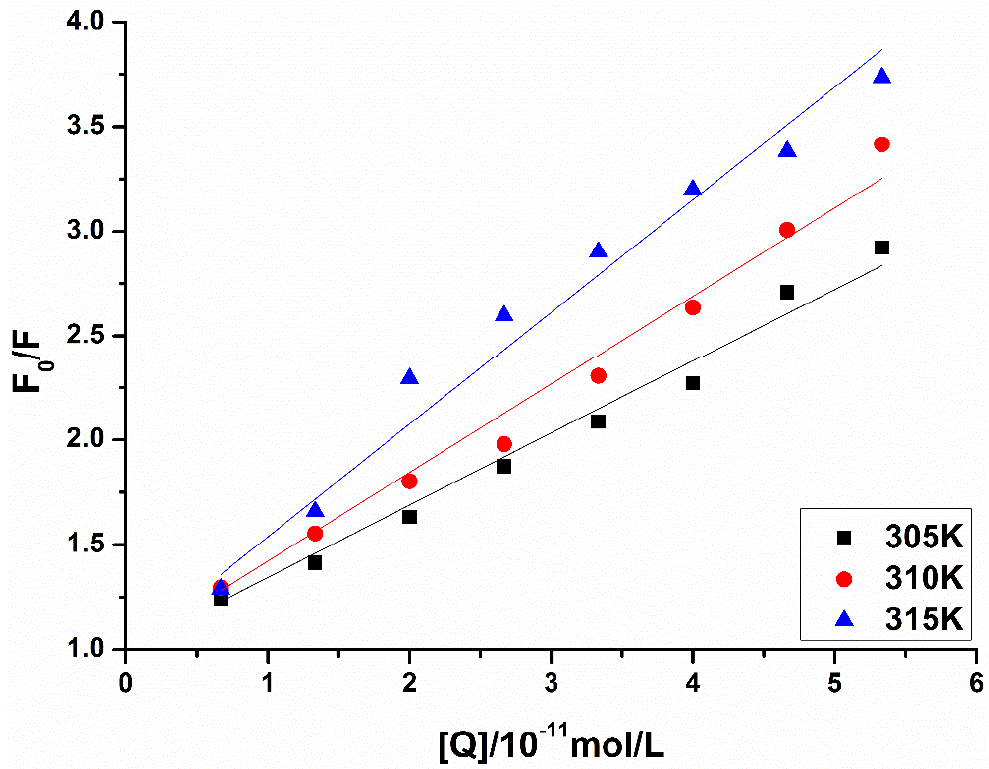
Table 4. The fluorescence intensity at different temperatures of LB before and after the addition of MAO-B.